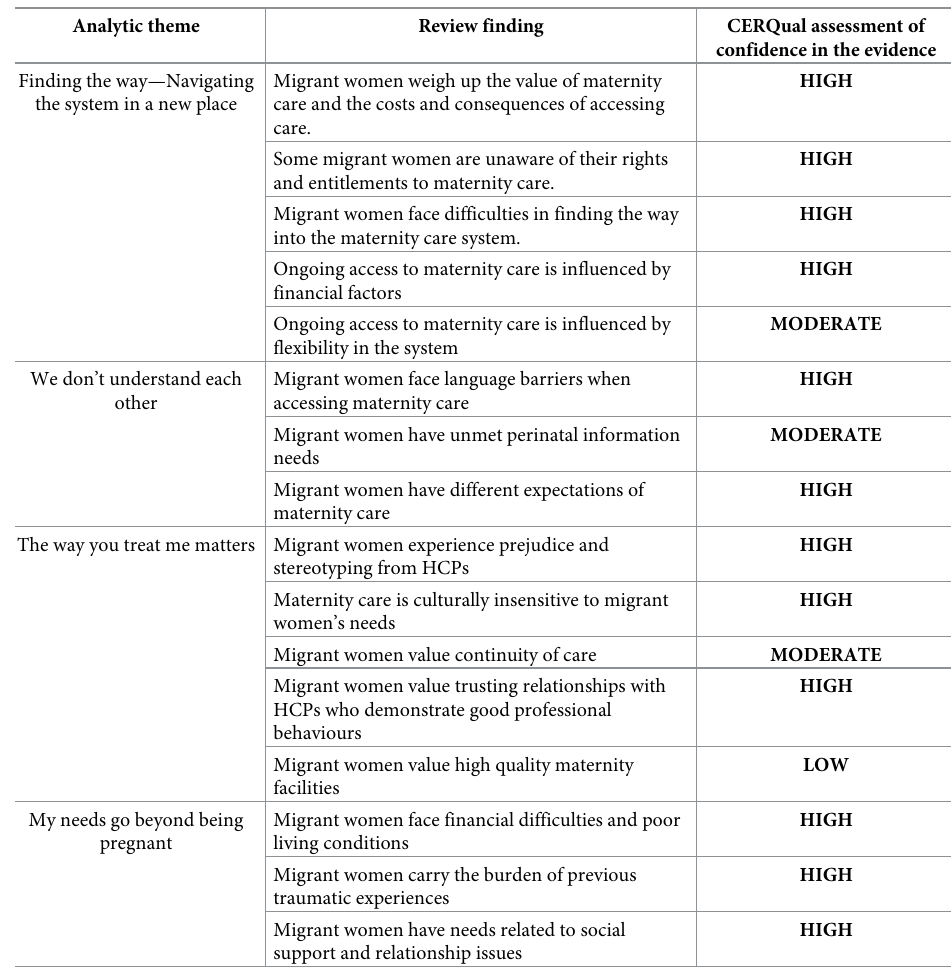
Table 3. CERQual summary